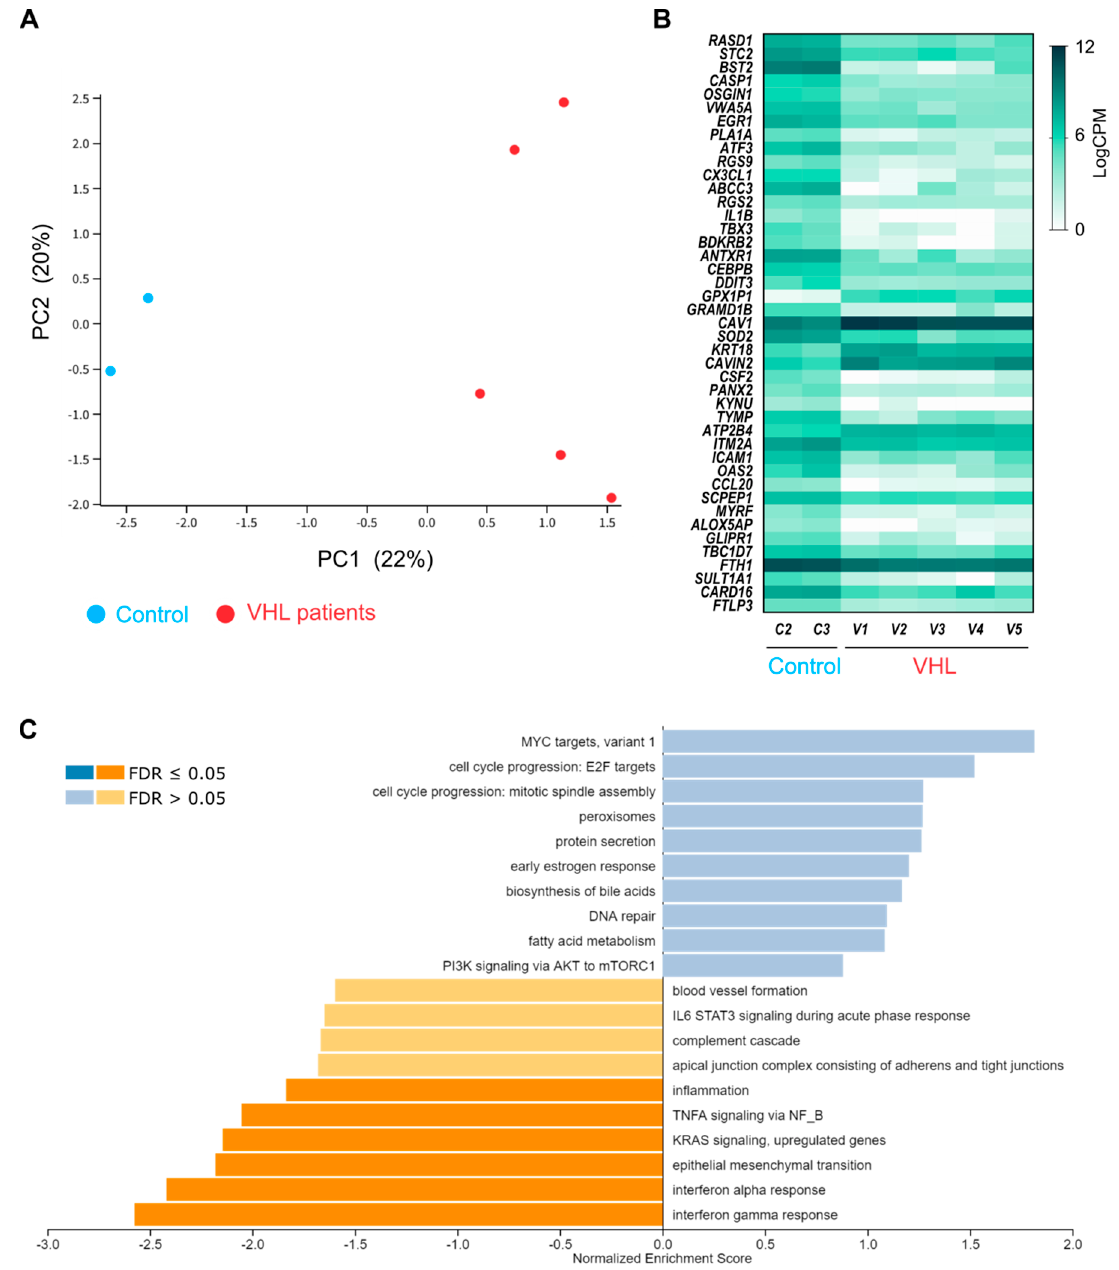
Figure 2. ( A ) Principal component analysis (PCA) showing the drift in transcriptome expression between control subjects (blue) and VHL patients (red). ( B ) Heat map of the logCPMs from control and VHL groups, taking only genes with adjusted p value < 0.05 in the PCA analysis. ( C ) Gene set enrichment analysis (GSEA) by Hallmarks of Cancer geneset. Blue shows over-represented genes (categorized by biological function) in VHL patients, as compared to control subjects. Orange shows unrepresented gene-sets in VHL patients.